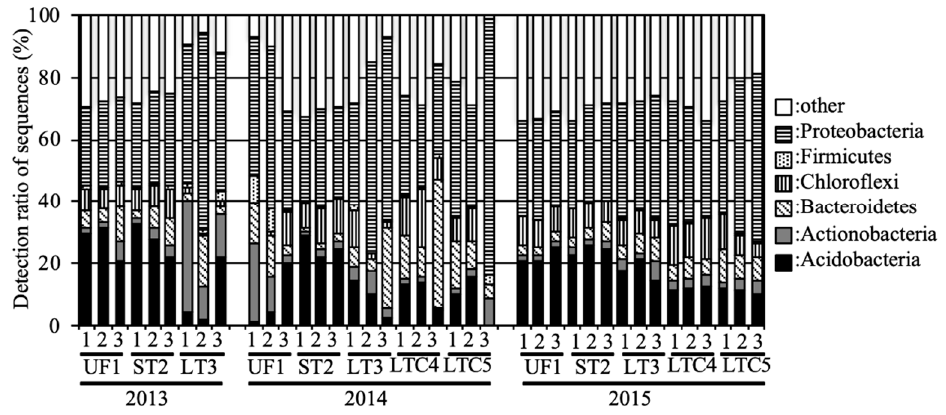
Figure 2. Relative abundances of the phyla in the soil samples. Percentages add up to the percentage of phylum Proteobacteria in Figure 2.